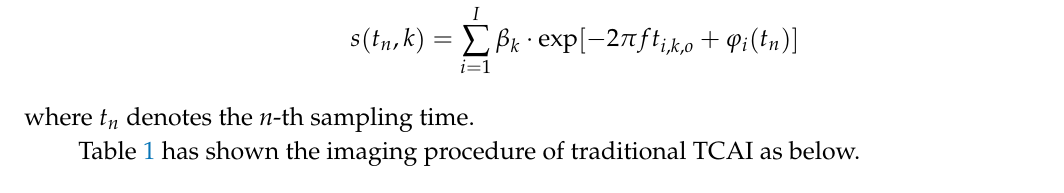
Table 1. Imaging procedure of traditional terahertz coded-aperture imaging (TCAI).